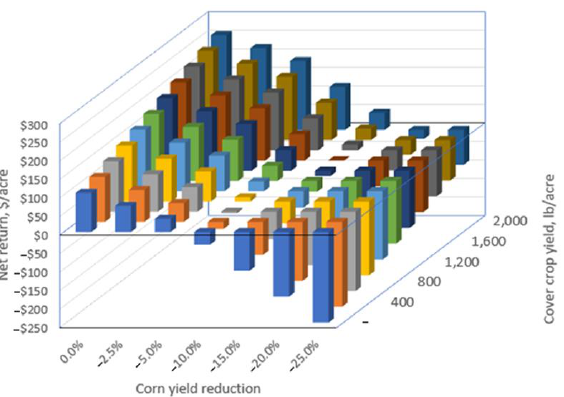
Figure 4. Net return difference from the base 76-cm row width scenario of 11.7 Mg ha − 1 corn grain when the stover is not baled or grazed. X and Y axes represent changes in the corn and cover crop yields, while the Z axis (vertical) shows the changes in net return/acre that resulted from each yield combination.